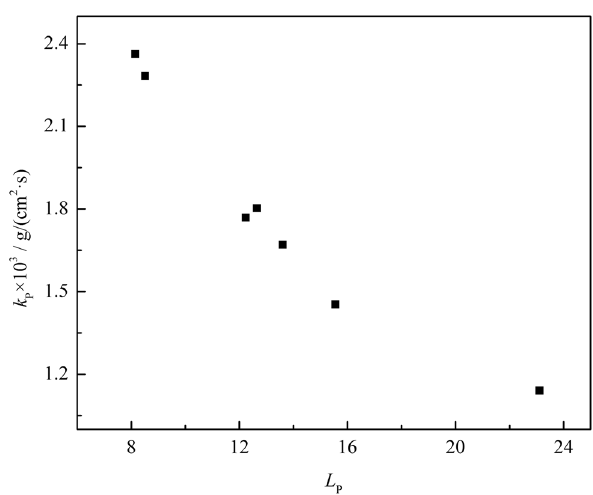
Figure 7: Relationship between k P and L P